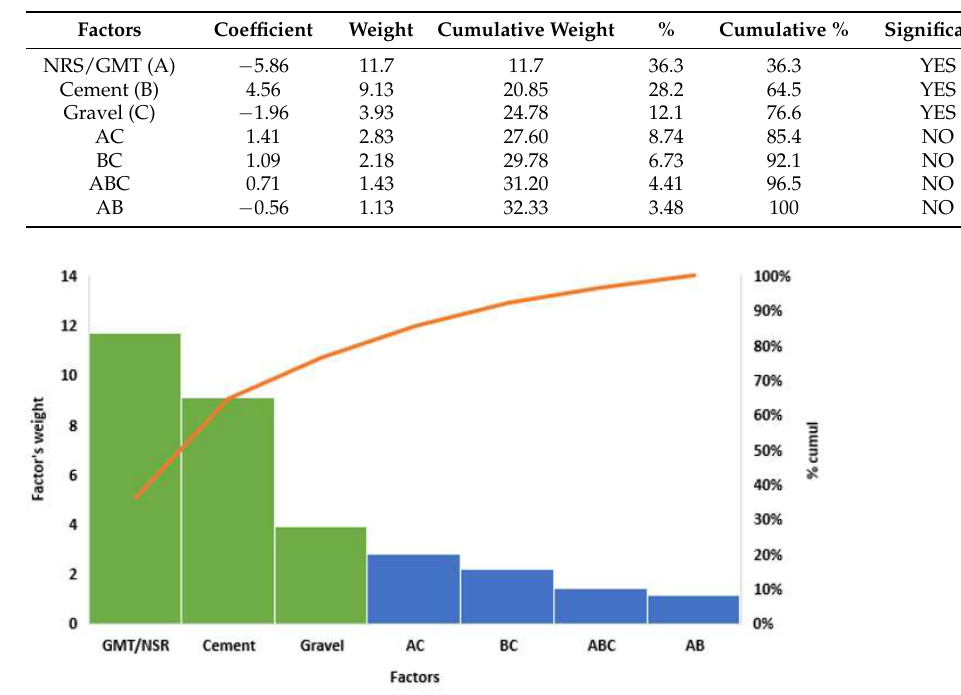
Figure 1. Pareto diagram of the study.